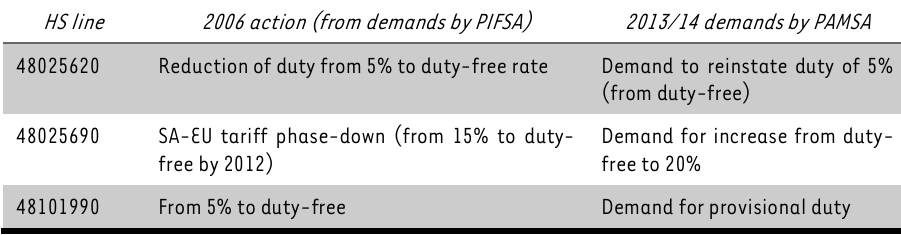
Tariff lines for duty